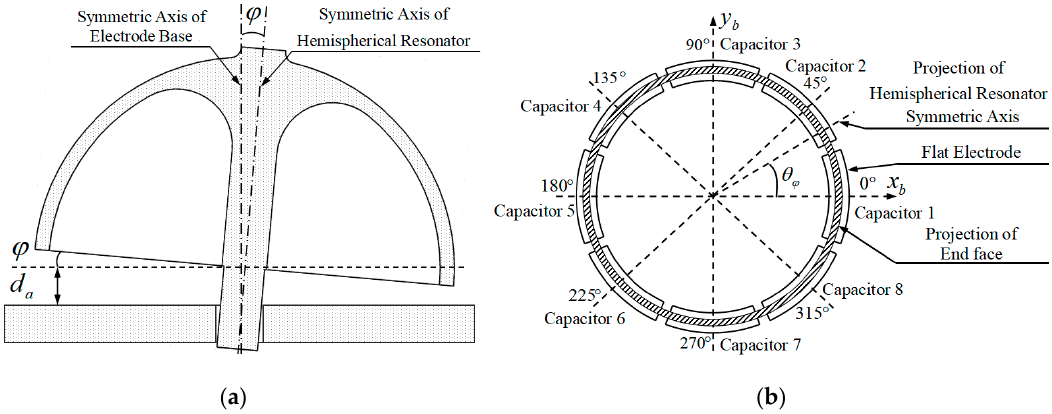
Figure 7. Assemble errors and parameters caused by assemble procedure: ( a ) Inclination angle of hemispherical resonator symmetric axis and average gap between end face of resonator lip and electrode base; and, ( b ) Direction angle of resonator symmetric axis.